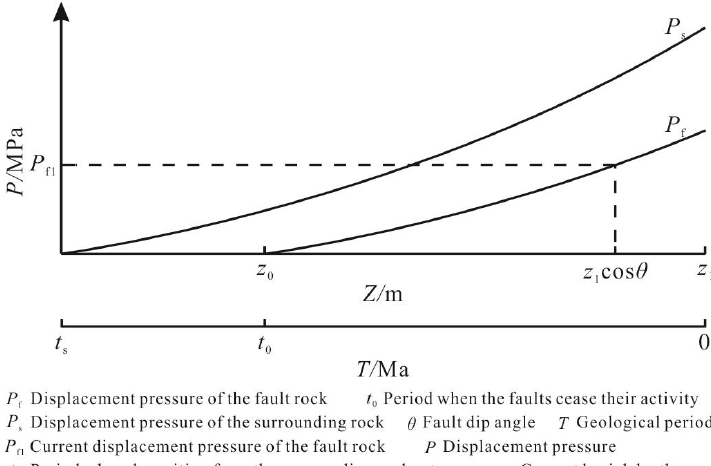
Figure 4. Calculation of displacement pressure of the fault rocks.